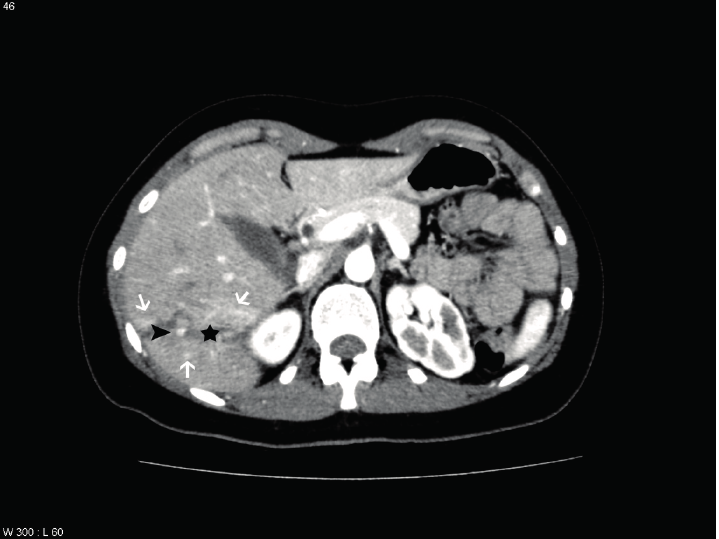
Figure 4. Patient with liver lesion in segment 5, 6, 7 and 8. PS/AF is seen within the lesion and THAD around the lesion. One observer missed the PS/AF. The liver lesion is marked with a black star, the areas with THAD are marked with white arrows and the pseudoaneurysm is marked with a black